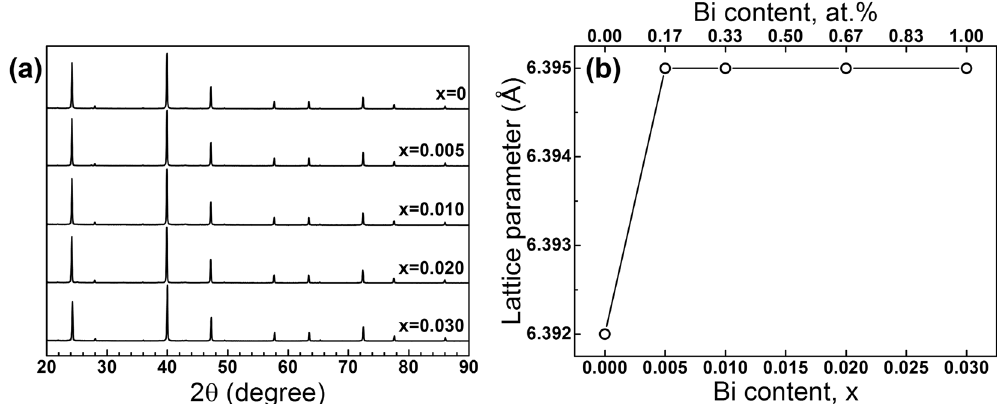
Figure 1. ( a ) XRD patterns and ( b ) lattice parameters of Mg 2 Ge 1 − x Bi x samples obtained by Rietveld refinement. Note that the lattice parameters do not change upon greater Bi addition beyond 0.17